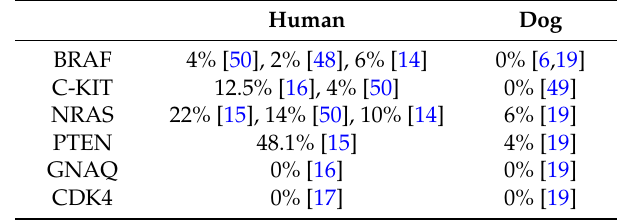
Table 2. Genes altered by mutations in canine and human mucosal malignant